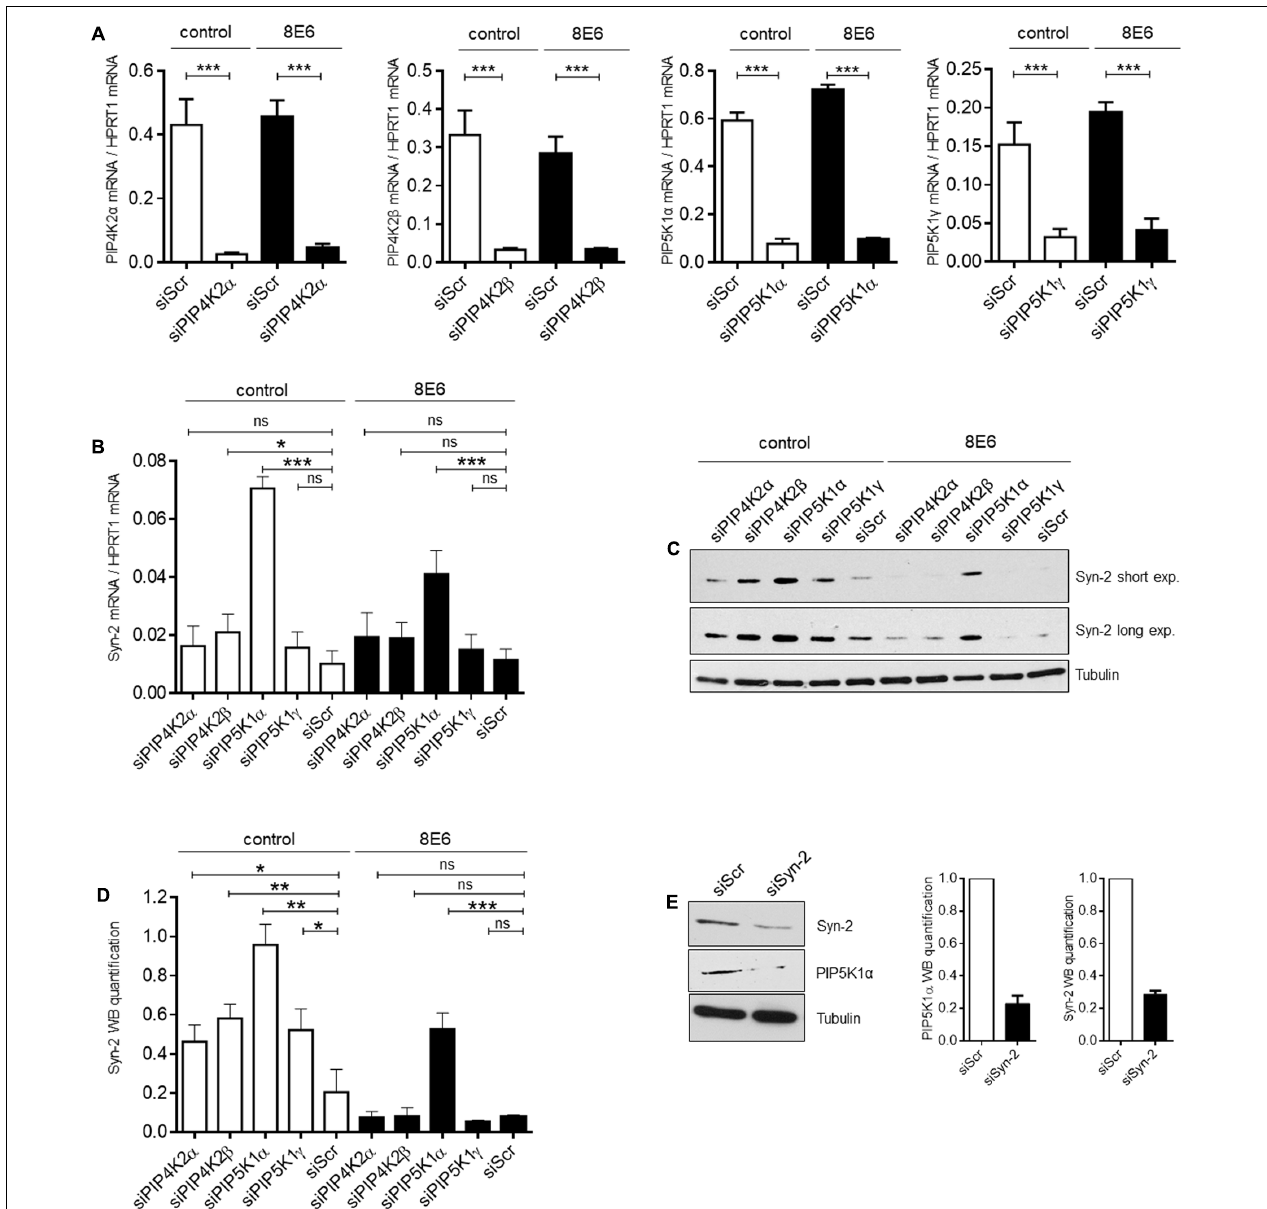
FIGURE 4 | PI(4,5)P 2 generating kinases are involved in control of Syntenin-2 expression. (A) Control (siScr), siPIP4KII α , siPIP4KII β , siPIP5KI α or siPIP5KI γ transfected N/TERT KGM -control and N/TERT KGM -8E6 cells were harvested 48 h post transfection and mRNA expression of kinase isoforms was determined by qRT-PCR ( n = 3 independent experiments, measured in duplicate). Data are presented as mean ± SEM ( ∗∗∗ p < 0.001). (B) Quantification of Syntenin-2 mRNA expression by qRT-PCR in N/TERT KGM -control and N/TERT KGM -8E6, in which the kinase isoforms PIP4KII α , PIP4KII β , PIP5KI α and PIP5KI γ were silenced by siRNA transfection. (C) Representative Western blot showing Syntenin-2 expression in total cell extracts from N/TERT KGM -control and N/TERT KGM -8E6, in which kinase isoforms were silenced by siRNA transfection. Equal loading was confirmed by immunoblotting for Tubulin. (D) Quantification of Syntenin-2 protein levels in cells treated with siRNAs for specific kinase isoforms ( n = 3 independent experiments). Data are presented as mean ± SEM. (E) Representative Western blot demonstrating downregulation of PIP5KI α protein levels in cells transfected with specific siRNA against Syntenin-2 (Left). Bars presenting the quantification of PIP5KI α and Syntenin-2 protein levels are shown in the Middle and Right ( n = 3 independent experiments). Data are presented as mean ±